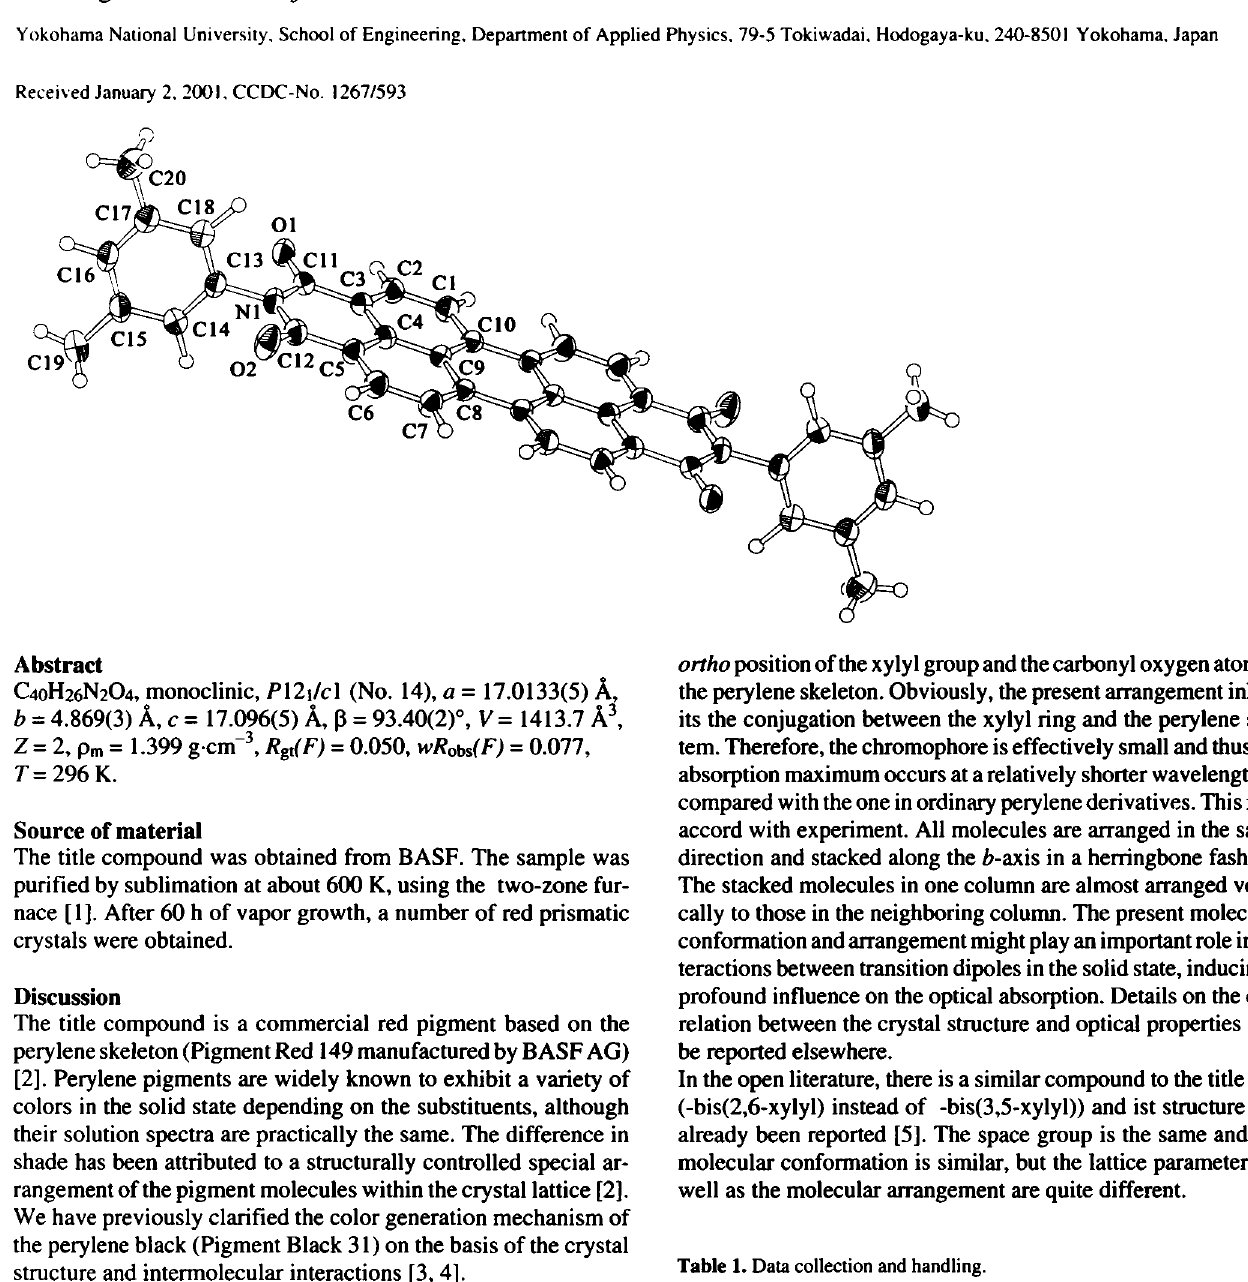
Table 1. Data collection and